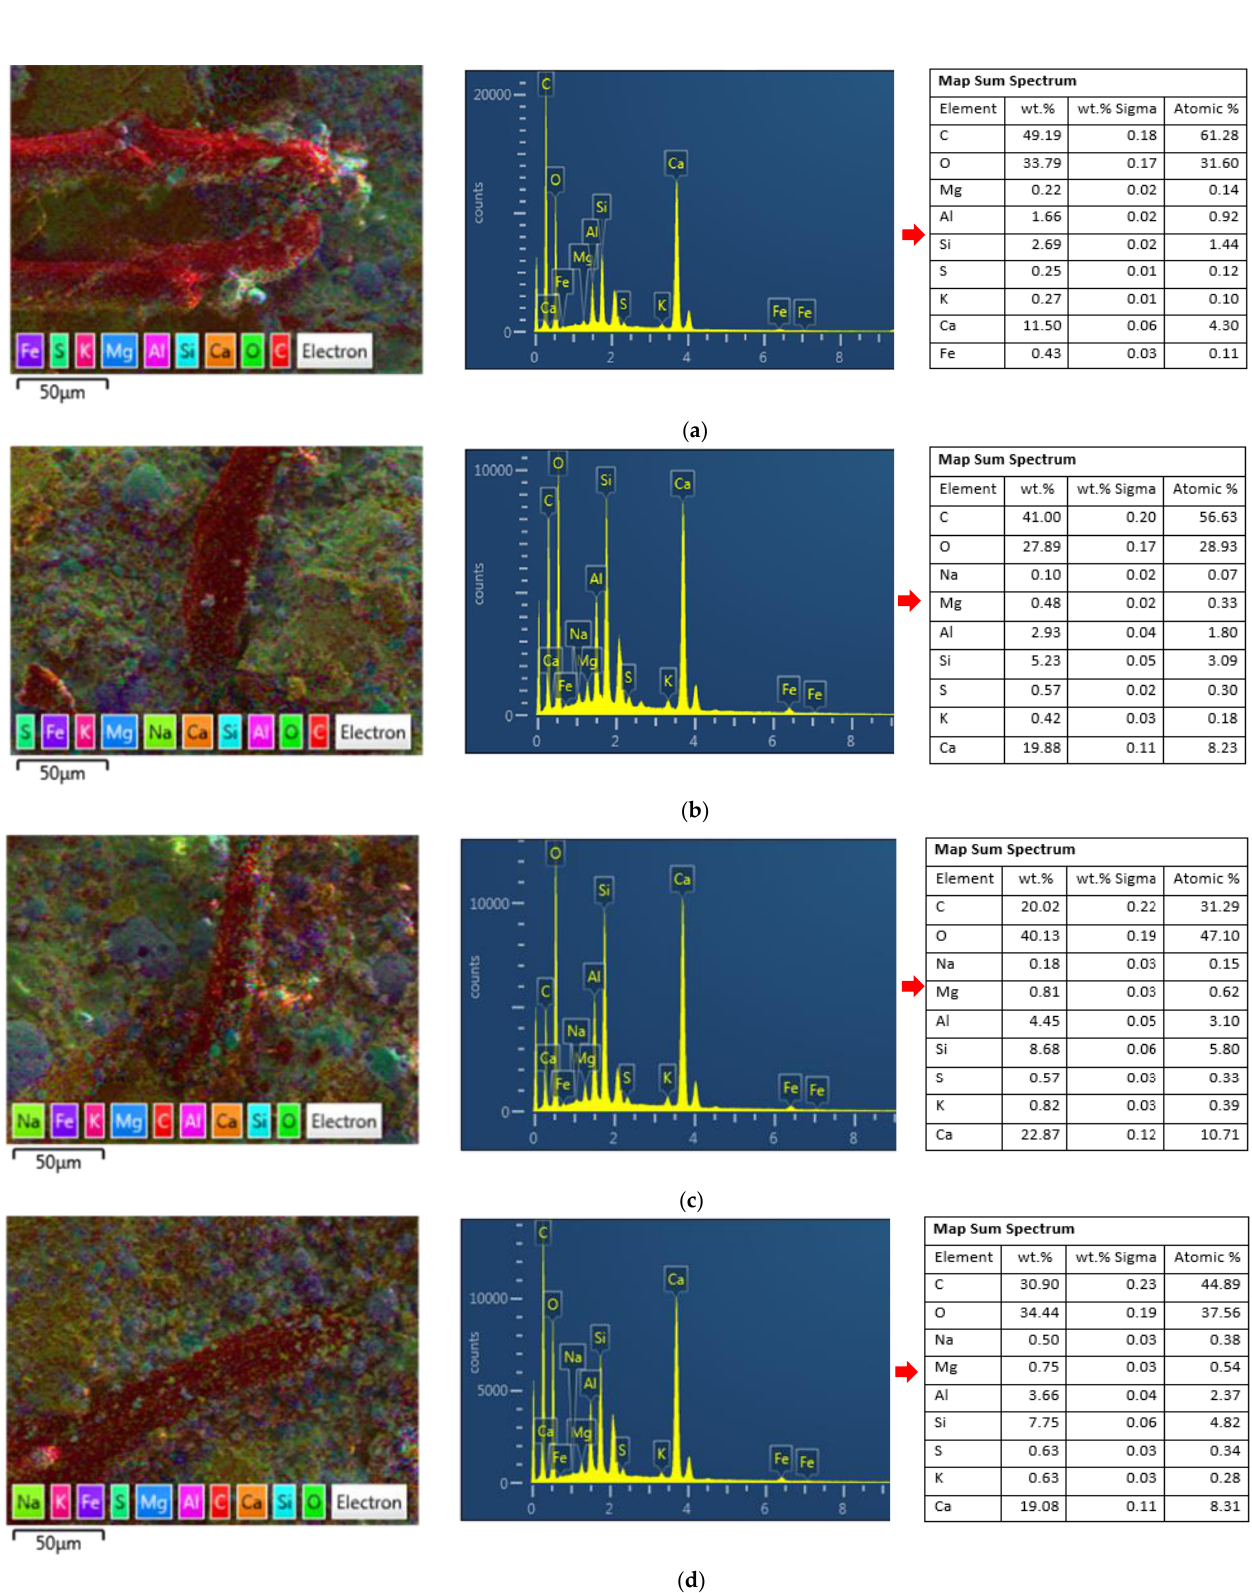
( d ) Figure 11. SEM results on day 7. ( a ) SF-0-60, ( b ) SF-5-55, ( c ) SF-10-50, ( d ) SF-15-45. Two EDS analyses were performed for each specimen: elemental analysis and map- ping analysis (Figure 12). The EDS elemental analyses showed that the surfaces of the